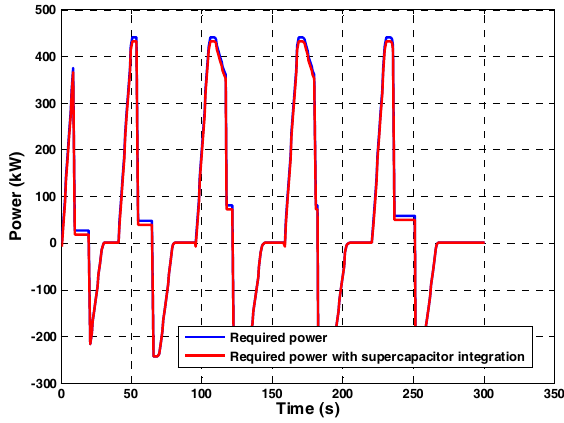
Figure 10. New power profile with integration of SC charged with photovoltaic modules.